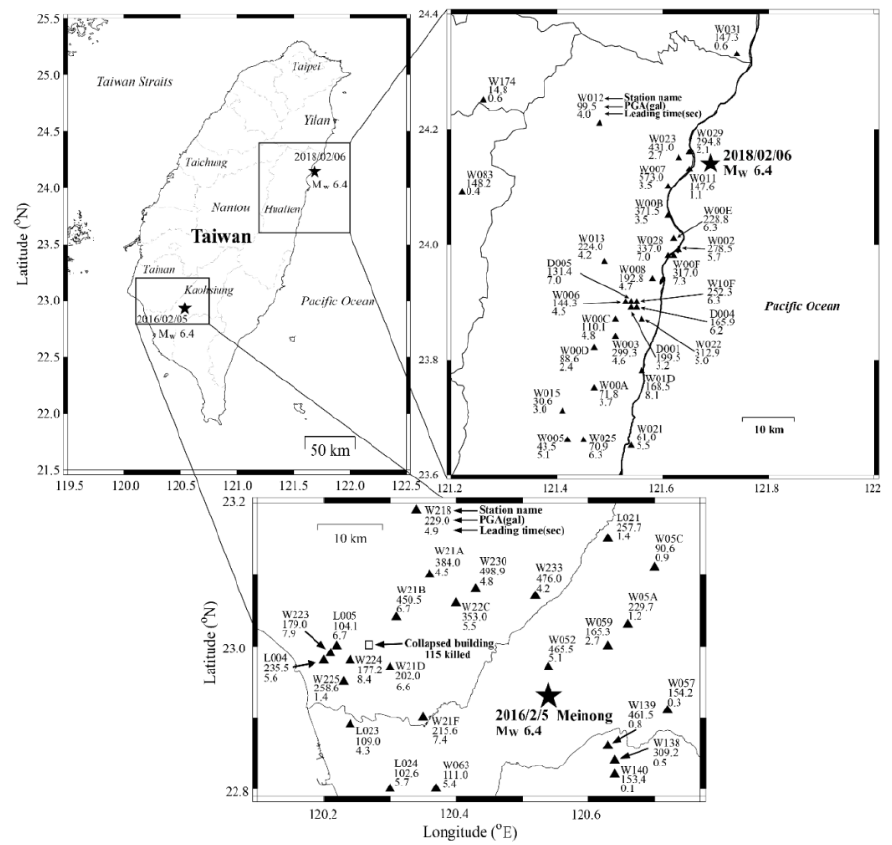
Figure 6. The on-site method can give warnings in the epicentral region where no regional warning is possible. P-Alert records from two earthquakes in 2016 and 2018 show the same trend as Wu and Kanamori (2008) [24] in Figure